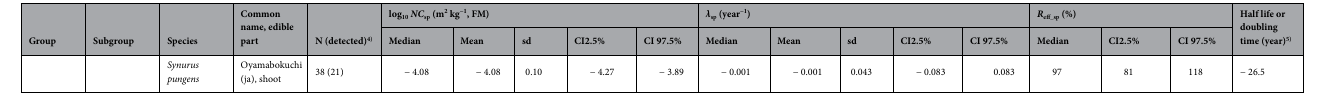
Table 1. Posterior distribution of normalized concentration ( NC sp ), temporal change parameter ( λ sp ), and effective annual change ratio ( R eff_sp ) of each species. 1) P. squarrosa is reported as poisonous. Also, it may contain similar edible species. 2) Among bamboo shoots, P. heterocycla (moso-bamboo) is the most popular in Japan but may contain multiple species. 3) "(ja)" indicates a Japanese name. 4) Number of parentheses indicates number of samples of which radioceisum concentration was detected. 5) Positive and negative values indicate